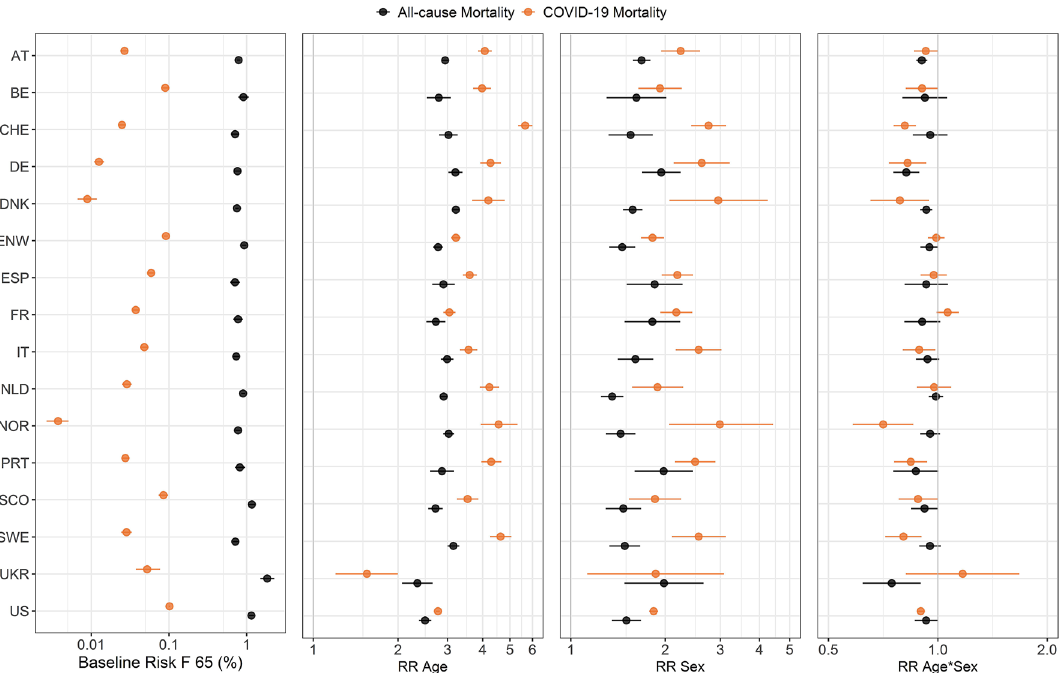
Figure 1. Analysis of all-cause and COVID-19 deaths depending on age and sex in 16 countries (Model 1). Estimates (dots) and 95% confidence intervals (lines) are obtained from the negative binomial model for COVID-19 deaths in 2020 ( Model 1 COVID ) and yearly all-cause mortality before 2020 ( Model 1 ALL ) for 16 countries. Given are the baseline risks for women at 65 years old (F 65), the risk ratios (RR) for age (per 10 years), for the male sex, and the interaction age × sex. Results for COVID-19 and all-cause deaths are in orange and black, respectively. Country codes are defined in Table